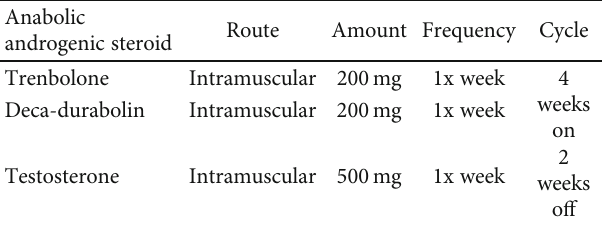
Table 1: The route, dosage, frequency, and schedule of anabolic- androgenic steroid (AAS) supplementation by the patient prior to each episode of